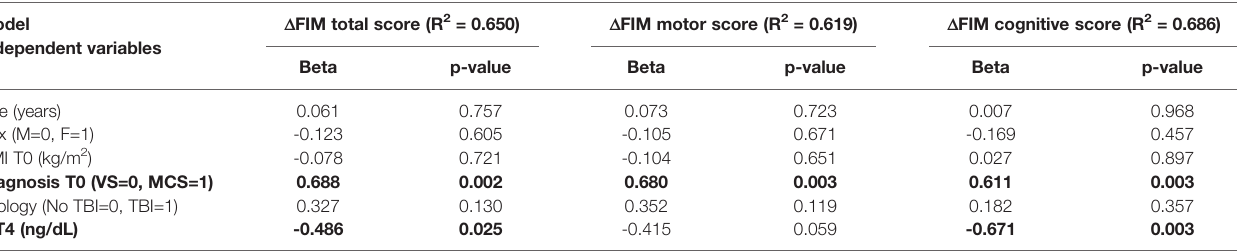
TABLE 5 | Multivariable linear regression analysis showing independent predictors for D FIM total, motor and cognitive score. Model Independent variables